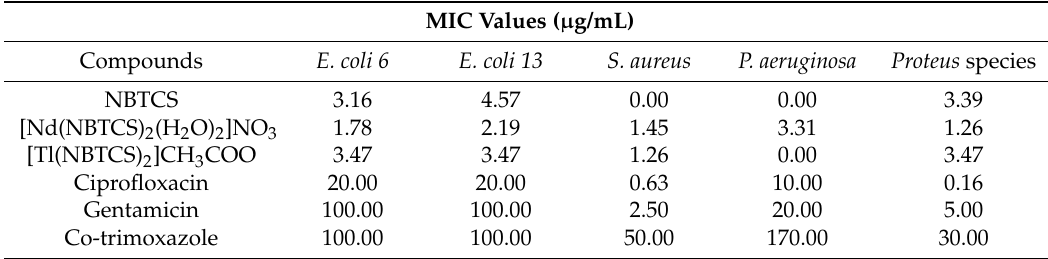
Table 5. MIC values of the compounds and standard drugs.